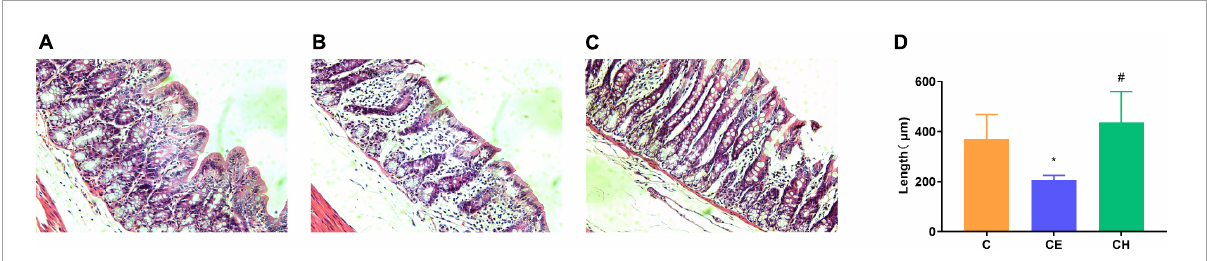
FIGURE4 Changes in histological morphology of the colonic mucosa at the end of the experiment. Histological morphology of the colon (HE, × 200). (A) C group; (B) CE group; (C) CH group; (D) Comparison of the villus length of colonic mucosa among different groups; Data are presented as the mean ± standard deviation ( n = 5). The means with different superscript letters are significantly different based on one-way ANOVA with LSD post-hoc analysis; *Means are significantly different vs. C group (* p < 0.05); # Means are significantly different vs. CE group ( # p < 0.05); C, control group; CE, cold exposure group; CH, Chinese herbs complex group.